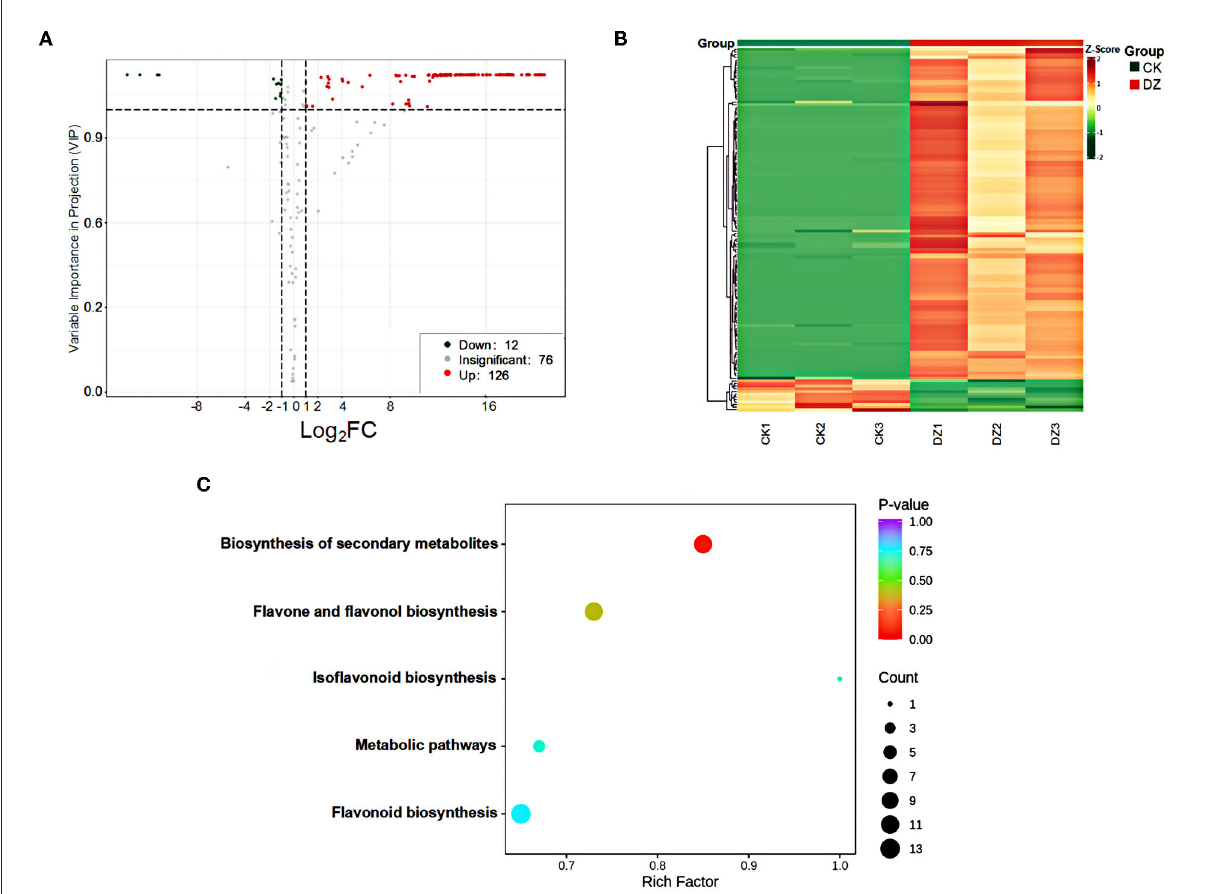
FIGURE3 Metabolic analysis of the traditional sweet rice wine (CK) and new product (DZ). (A) Volcano plot; red represents upregulated metabolites, green represents downregulated metabolites, and gray represents metabolites detected but not significantly different; (B) heatmap and cluster analysis of different sweet rice wine samples at the metabolome level. Green indicates low abundance, and red indicates high abundance; (C) KEGG analysis of the differential metabolites in the sweet rice wine samples. The x-axis represents the richness factor. The color and size of the dots represents p -value and the amount of enriched differential metabolites,